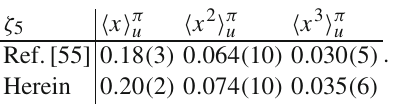
Fig. 5 a Solid blue curve – valence-quark distribution in Eq.(29) evolved to ζ = ζ 5 = 5 . 2GeV, using the procedure explained in Sect.4.1; and long-dashed black curve – result from Ref. [102] at this scale. Dot-dot-dashed (grey) curve within shaded band – lQCD result [55]. Data (purple) from Ref. [111], rescaled according to the anal- ysis in Ref. [50]. Comparing our central prediction with the plotted data, one obtains χ 2 / d . o . f . = 1 . 66. b Solid green curve, p = g – our prediction for the pion’s glue distribution; and dot-dashed red curve, p = S – predicted sea-quark distribution. Normalisation convention: (cid:2) x [ 2 u π ( x ; ζ ) + g π ( x ; ζ ) + S π ( x ; ζ ) ](cid:3) = 1. (The uncertainty bands 5 5 5 bracketing our results are explained in the